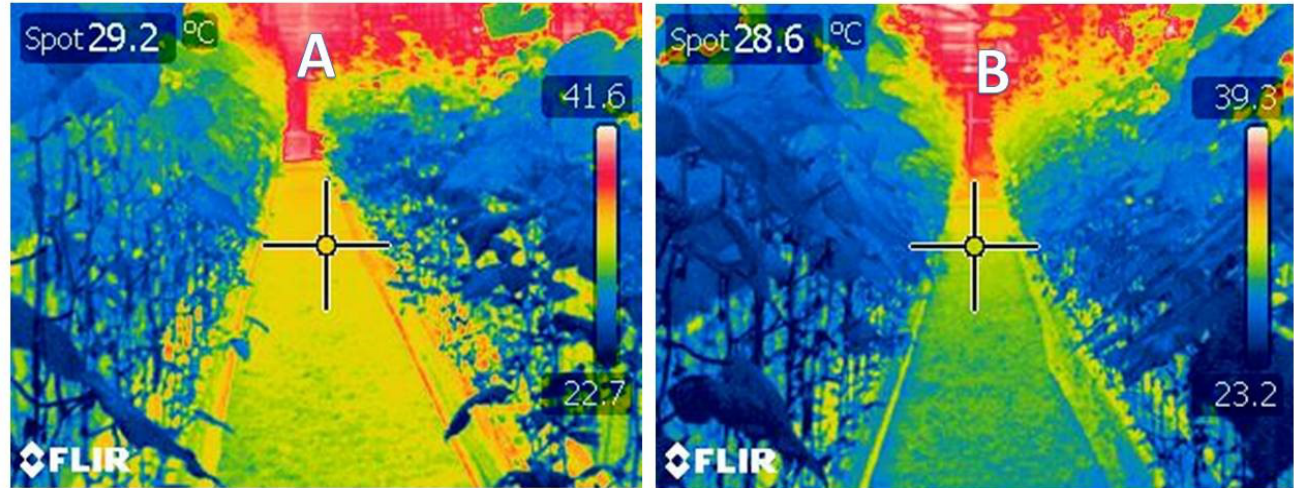
Figure 16. Thermal image of plant inside the greenhouse. ( A ) plant irrigated using digital timer control system ( B ) plant irrigated using growing medium moisture sensor. Both images were taken inside the same greenhouse at the same time (11.00 AM). The image B shows a lower temperature using the growing medium moisture sensor, due to the regularity of the irrigation